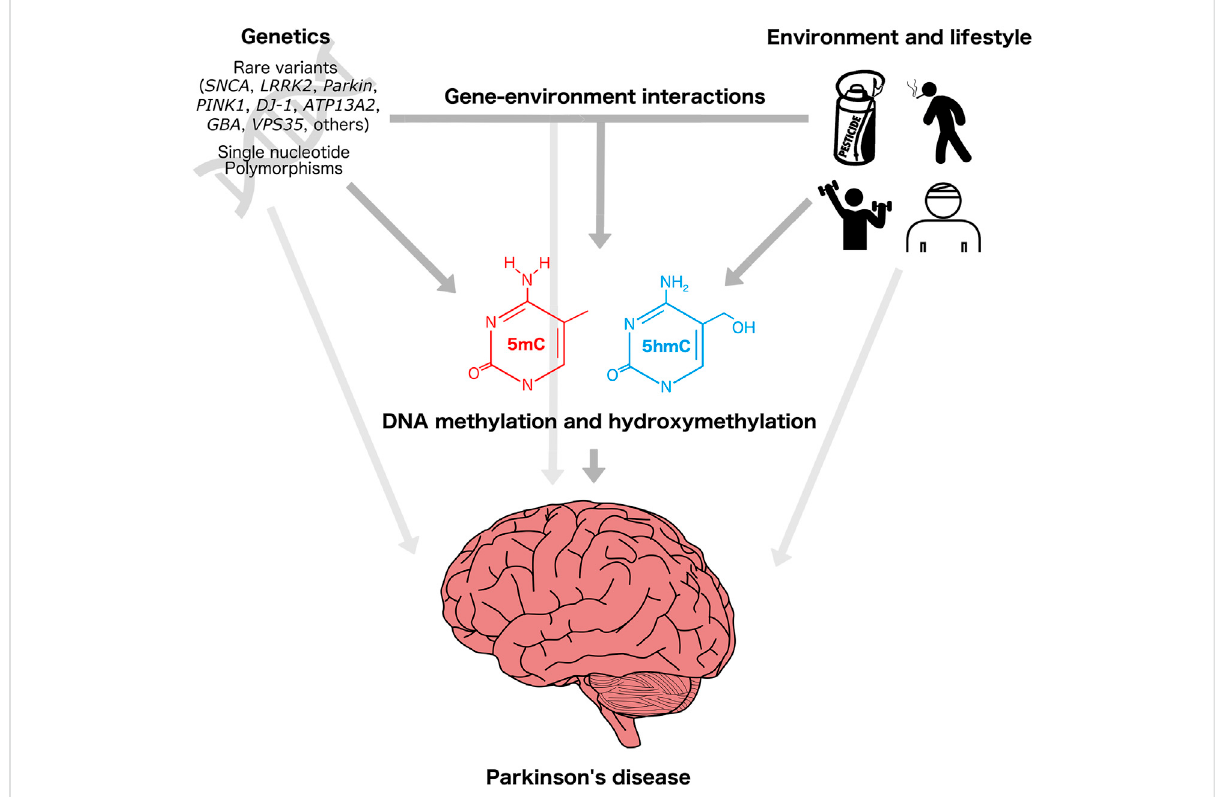
FIGURE 2 Genetic, environmental, and epigenetic underpinnings of Parkinson ’ s disease. Individual genetic background, environmental exposures (e.g., pesticides), and lifestyle-related factors (e.g., exercise, smoking, head trauma) in fl uence PD risk. These factors may act directly or indirectly through modi fi cation of DNA methylation and/or DNA hydroxymethylation patterns, which in turn can in fl uence the regulation of genes involved in